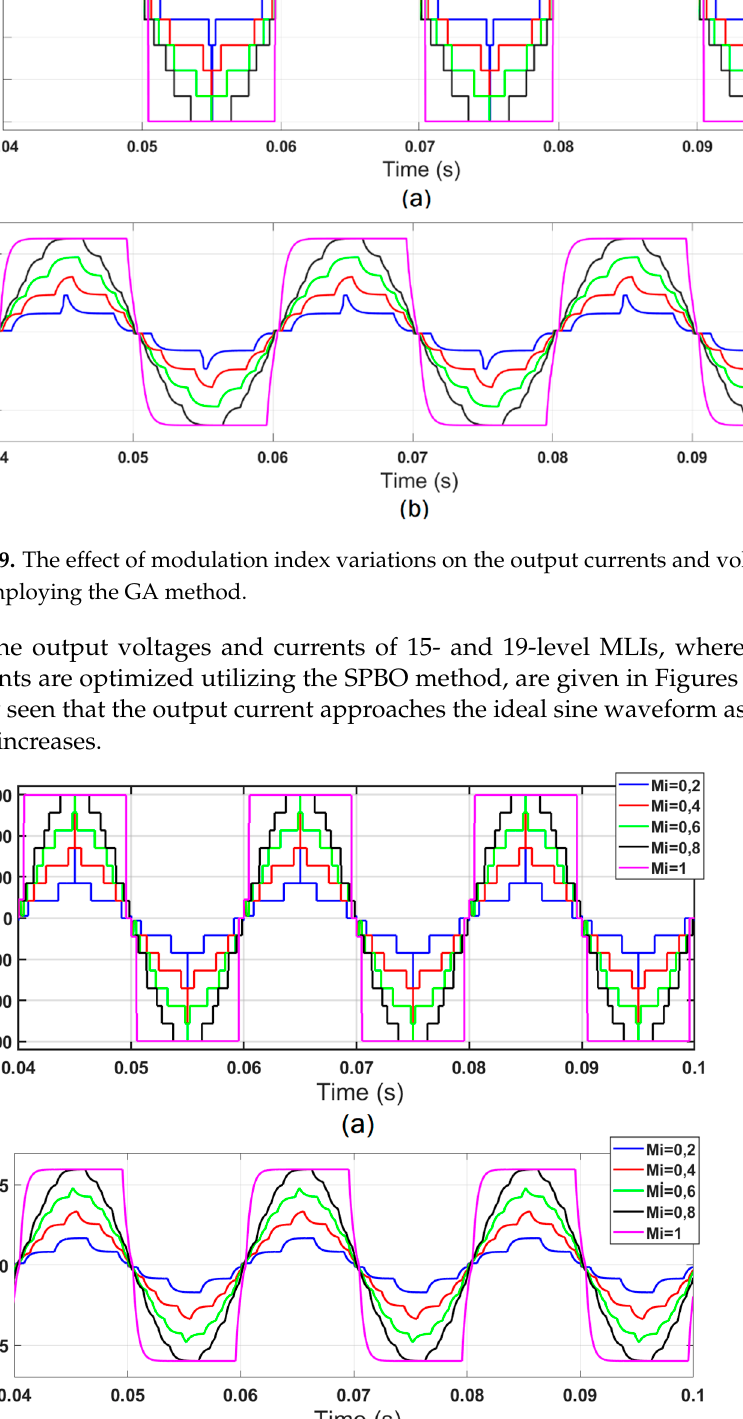
Figure 11. The effect of modulation index variations on the output currents and voltages of 19 − level MLI employing the SPBO method.